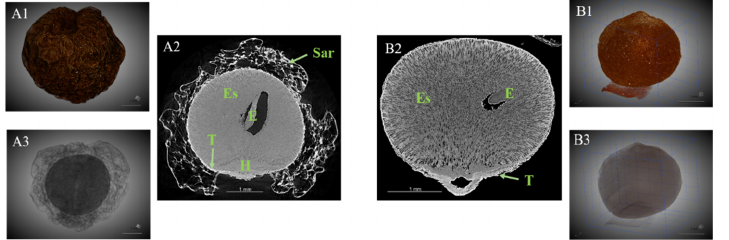
Figure 4. Illustration of seed structure of G. superba seed by micro-T. ( A1 – A3 ) Non-scarified seed; ( B1 – B3 ) Scarified seed; Sar—sarcotesta, T—tegmen, Es—endosperm, E—embryo, H—hilum. The overall porosity and pore network in the seed structures were also